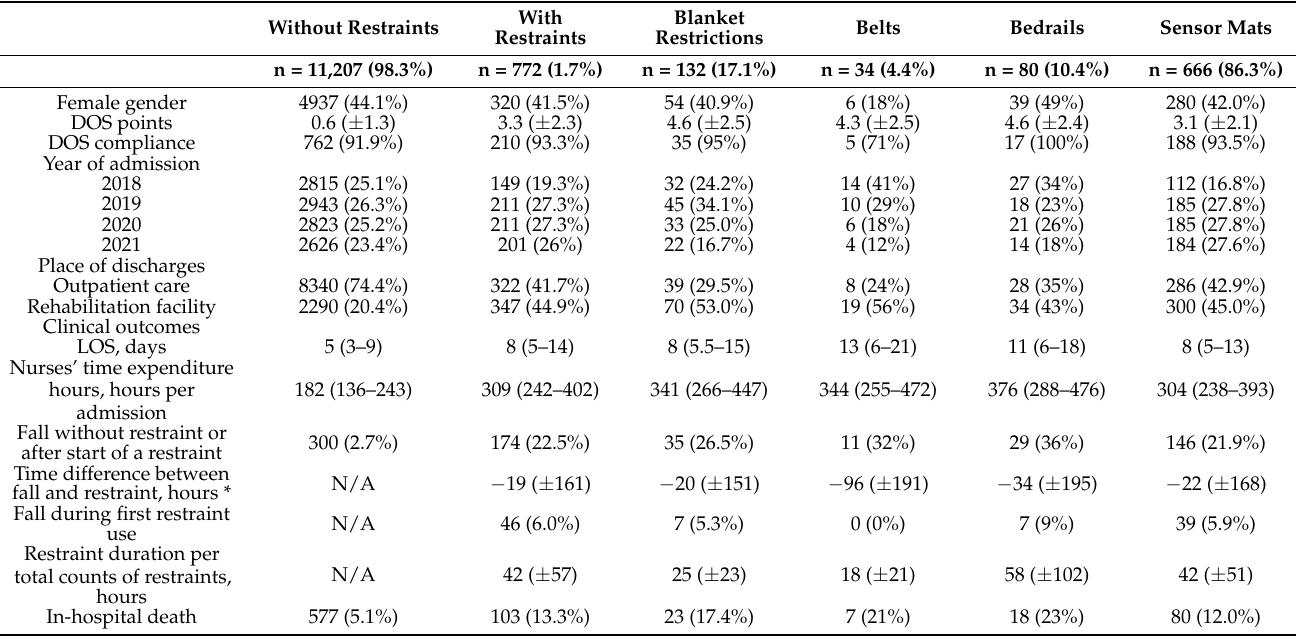
Table 2. Falls and outcomes among different types of